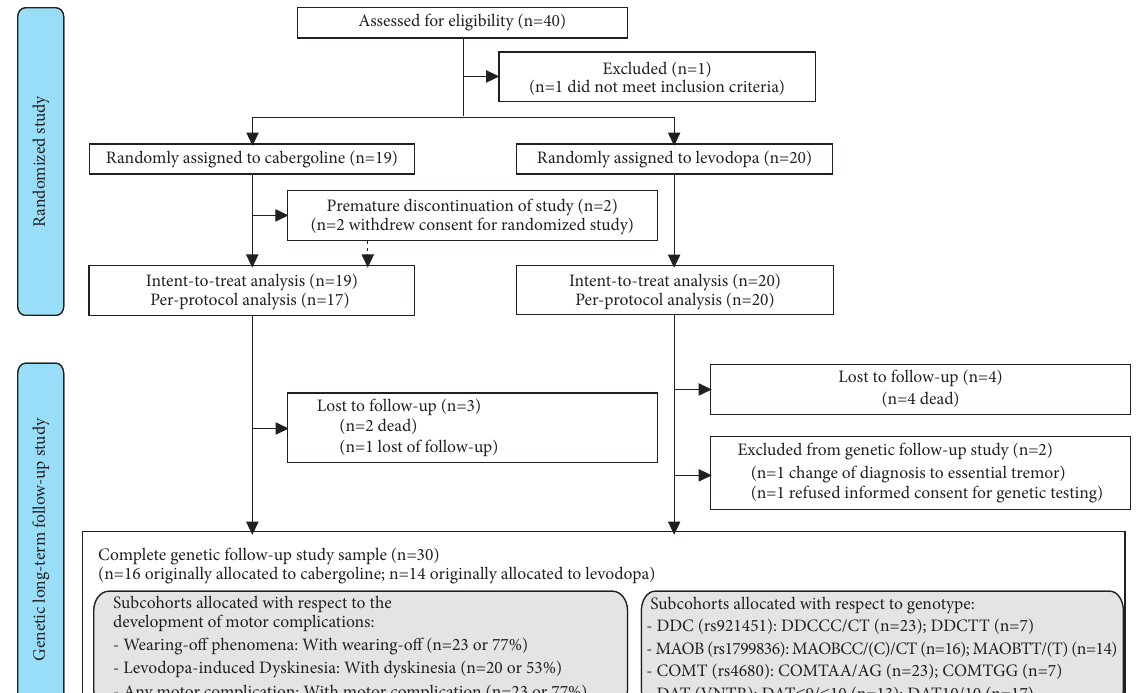
Figure 1: CONSORT flow diagram for the